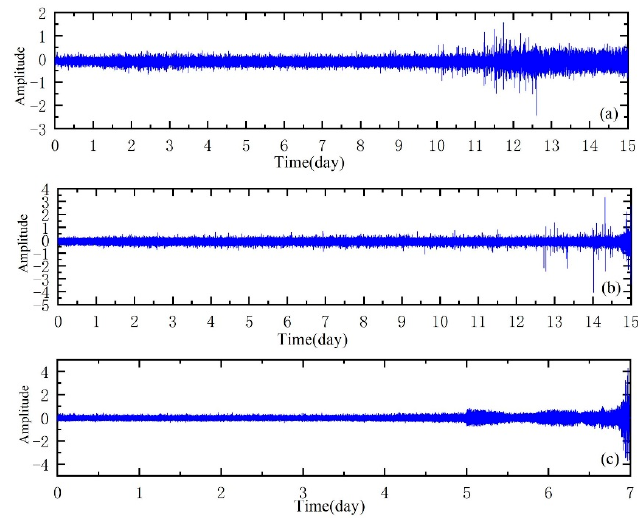
Figure 4. Whole-life vibration signals of bearings.